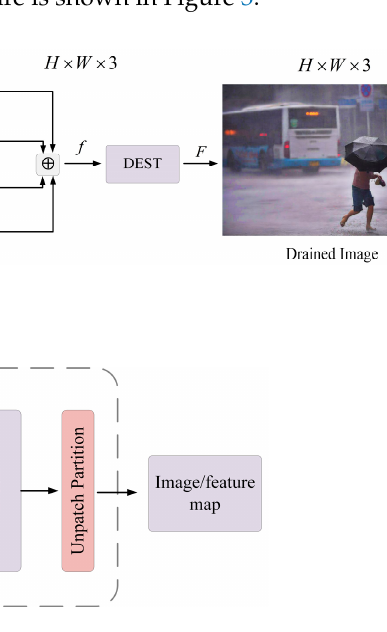
Figure 1. The overall architecture of pedestrian and vehicle detection on rainy days. The new net- work could accurately complete the task of rainy image object detection and image deraining.